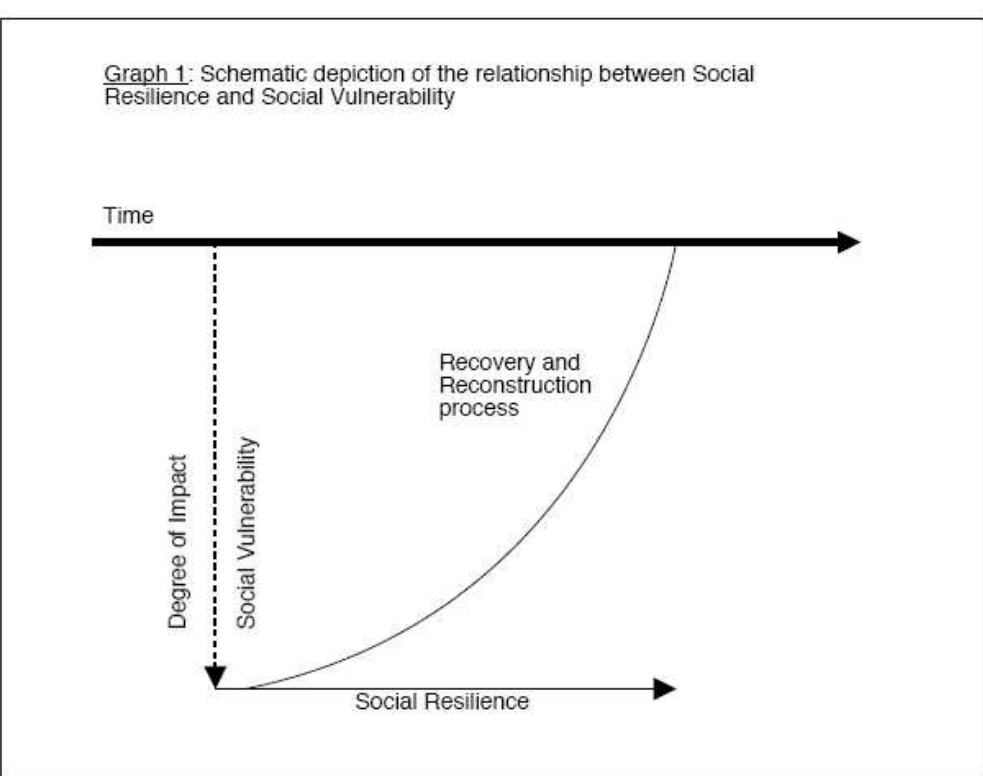
While they might interact with respect to their effect on community capacity, they are not directly correlated with each other. Moreover, they are measured in different